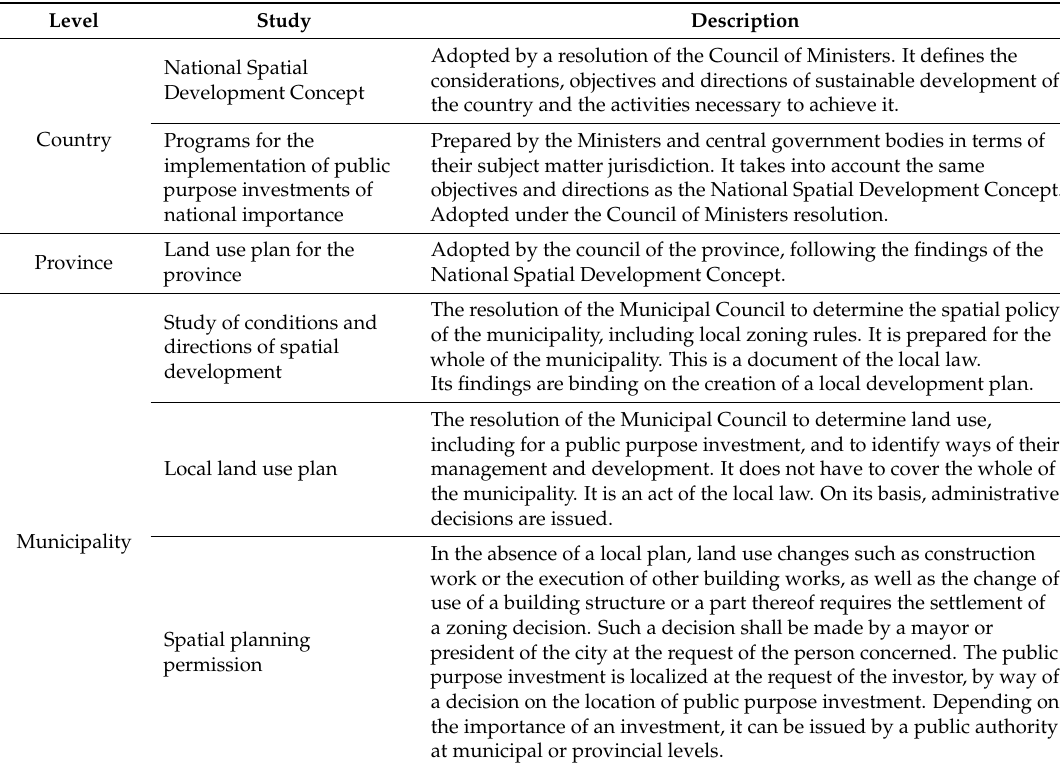
Table 2. Planning studies for land areas. Source: own study based on [44].